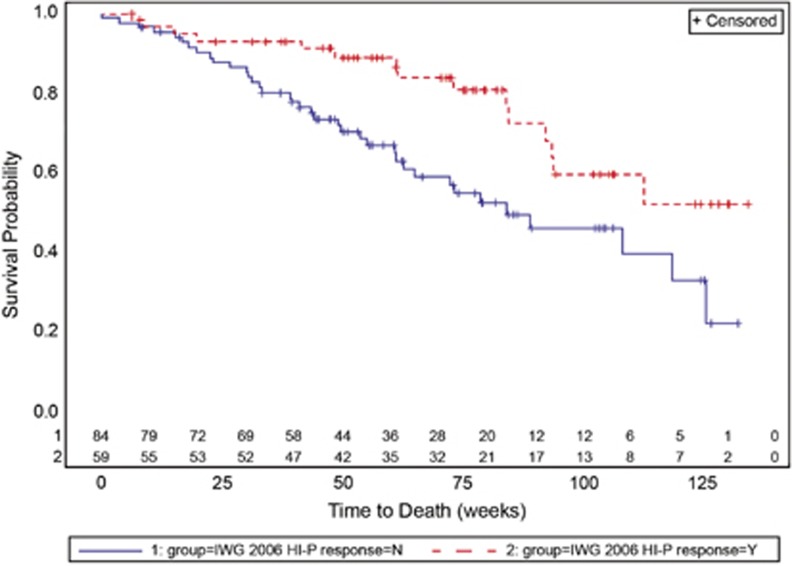
Survival curves. Shown are the survival probability for those who had achieved an IWG 2006 HI-P response (red dashed line) and those who did not (solid blue line), all in romiplostim-treated patients. Number of patients at risk is shown on the graph immediately above the x axis. P=0.0070 by log-rank test.